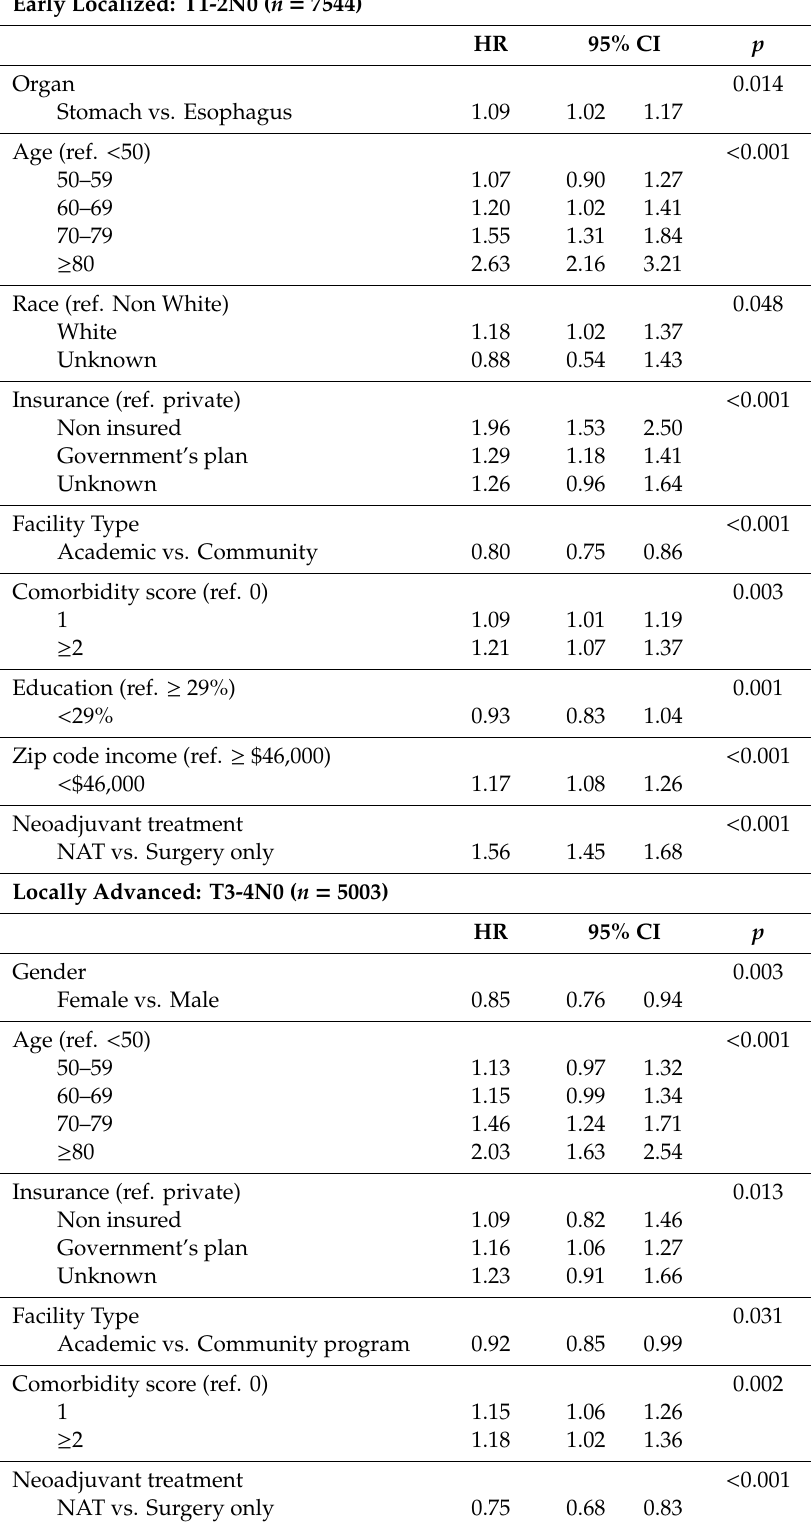
Table A2. Cox regression model for overall survival by clinical stage of gastroesophageal adenocarcinoma. Early Localized: T1-2N0 ( n =